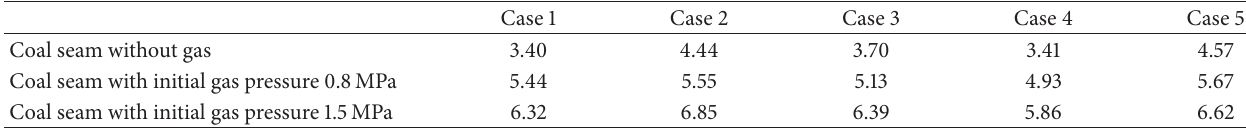
Table 3: The plastic zone of the coal mass in front of the roadway (m 3 ). Case